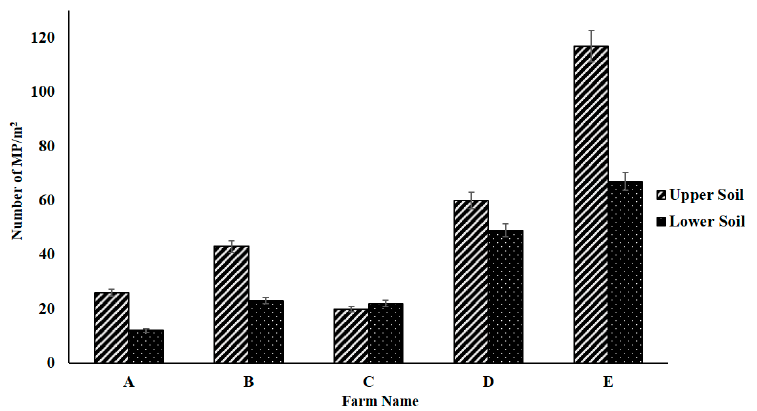
Figure 3. MPs abundance in farmlands under the study at different depths. Table 3. Statistics of MPs abundance for different sample types.